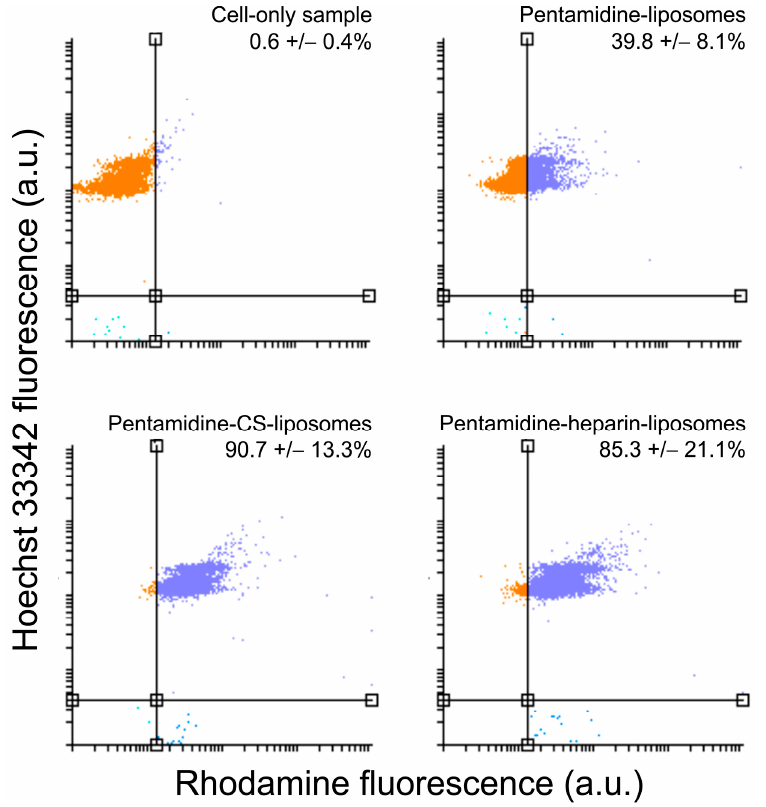
Figure 5. Flow cytometry analysis of liposome targeting to RAW 264.7 macrophages after 3 h of incubation. The vertical line indicates the threshold set to separate rhodamine-free cells (orange dots) from rhodamine-stained cells (purple dots). a.u.: arbitrary units. Mean values ± standard deviations are indicated ( n = 3).